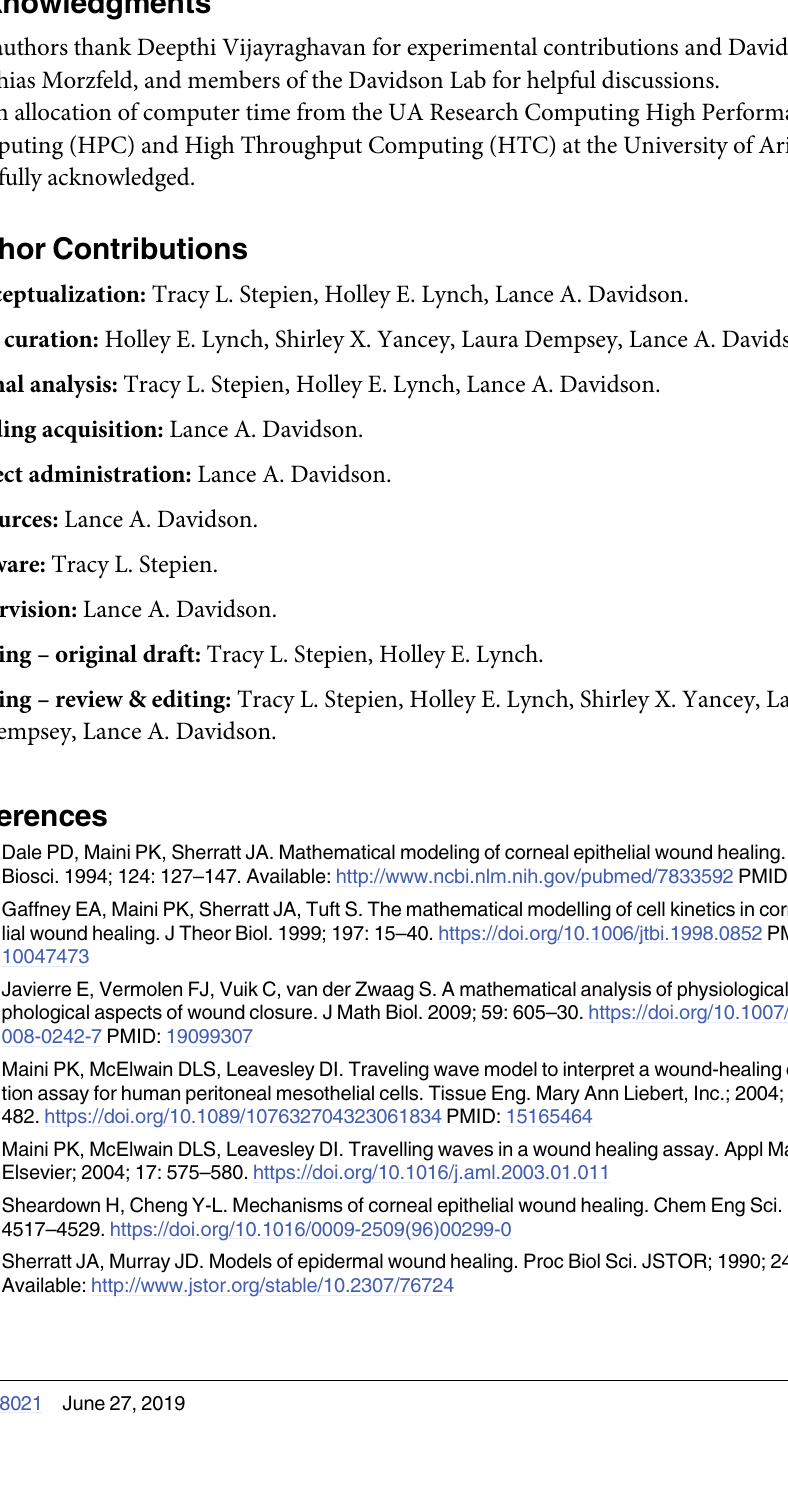
S10 Video. Time-lapse sequences of still images in S3B Fig. (AVI) S11 Video. Time-lapse sequences of still images in S3C Fig. (AVI) S12 Video. Time-lapse sequences of still images in S3D Fig.